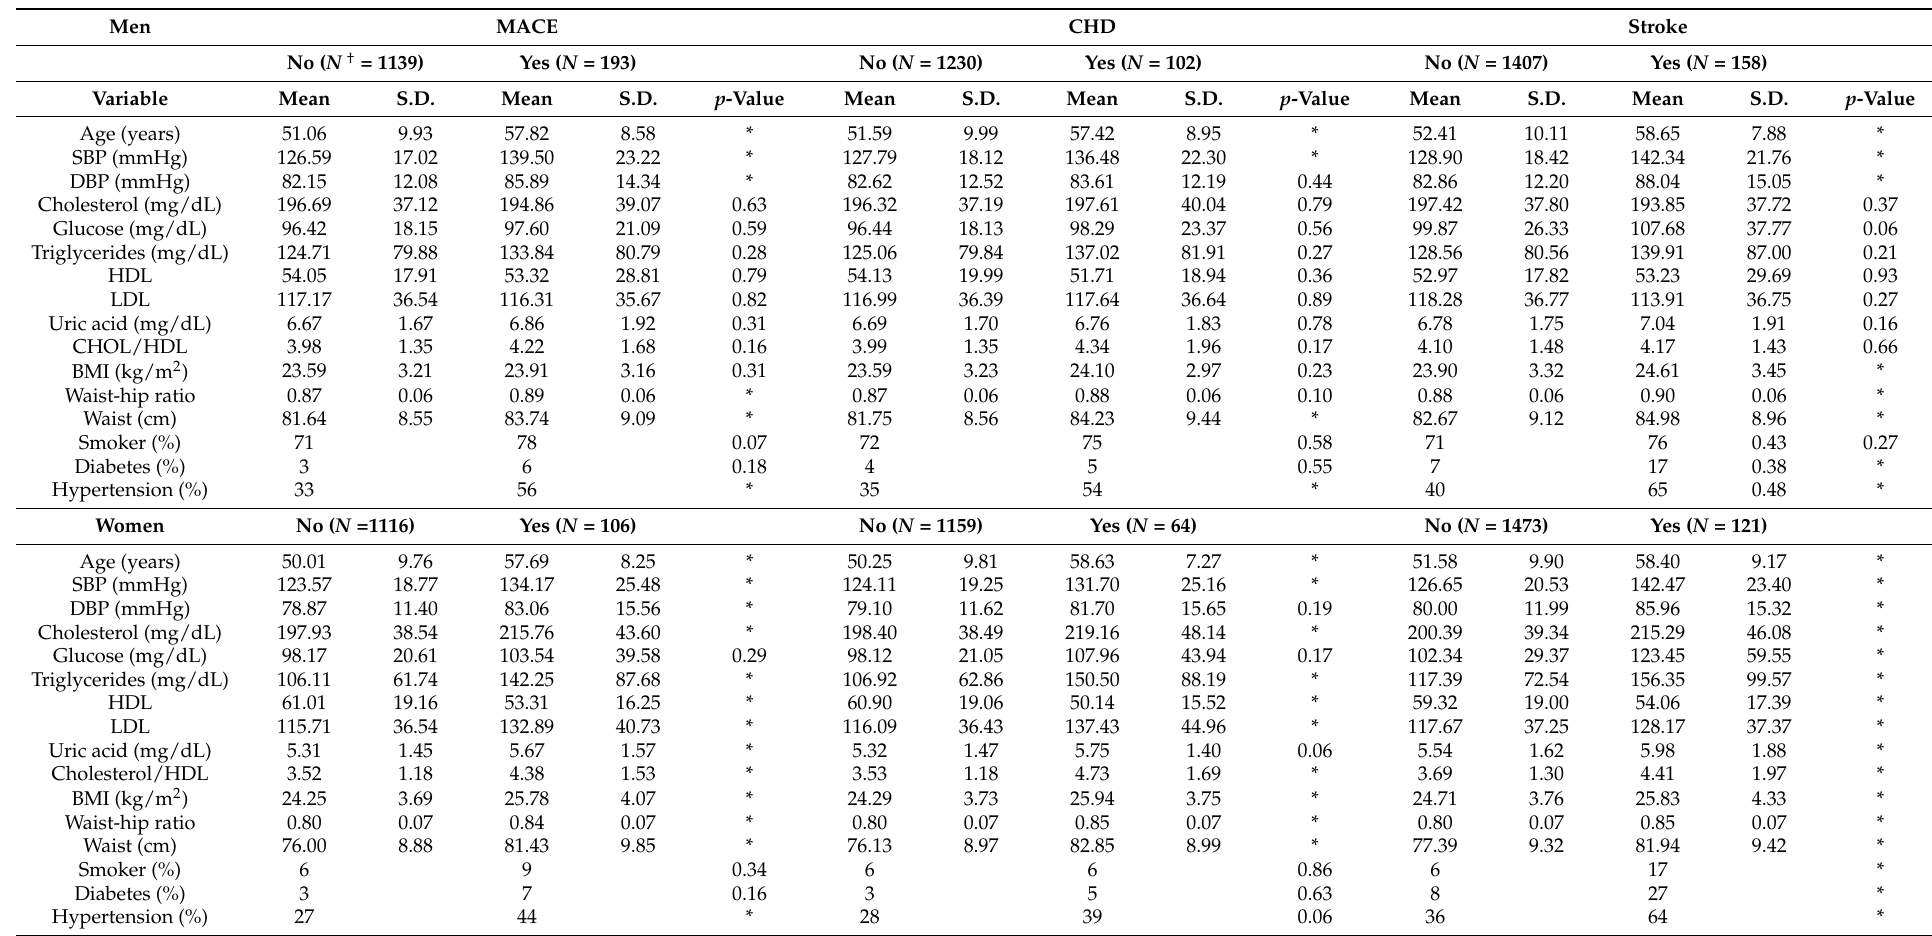
Table 1. Comparisons of baseline values between patients who developed MACEs, CHD, or stroke over a 10-year period and those did